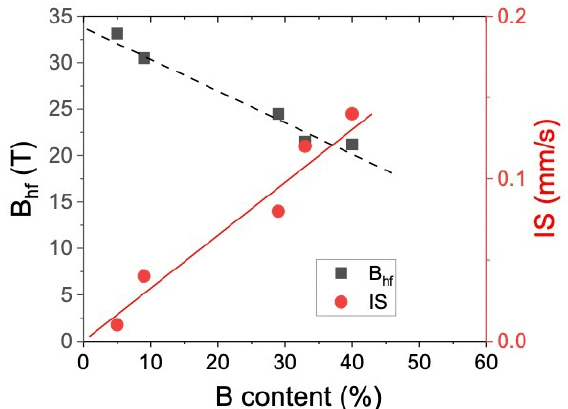
Figure 7. The dependence of average B hf (black points) and IS (red points) versus the real B content in the intermetallic Fe ‐ B thin films obtained by TVA.